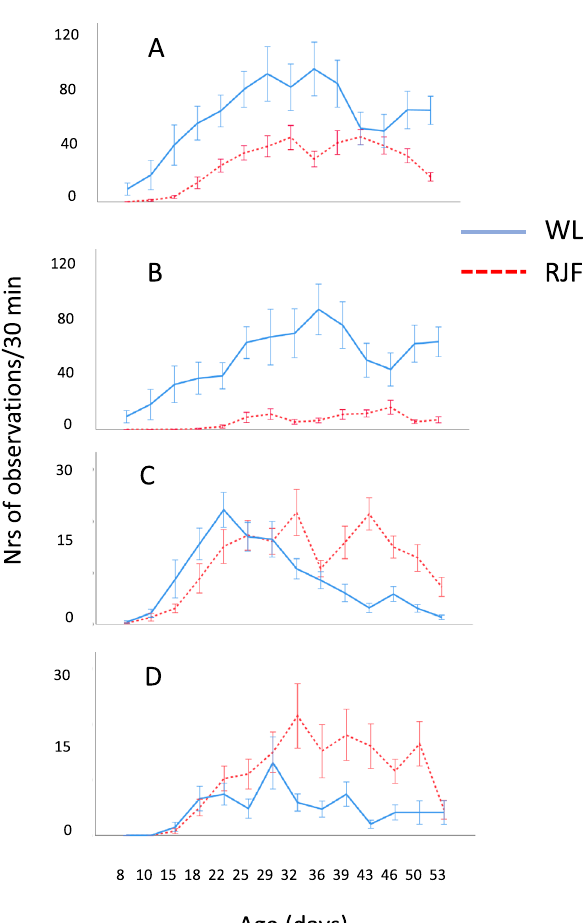
Figure 1. Mean number of observations (± standard error) per group per 30 min of ( A ) total play, (B) object play, ( C ) locomotor play, and ( D ) social play at different ages in Red Junglefowl and domesticated White Leghorn chicks. Note that the scales differ between the